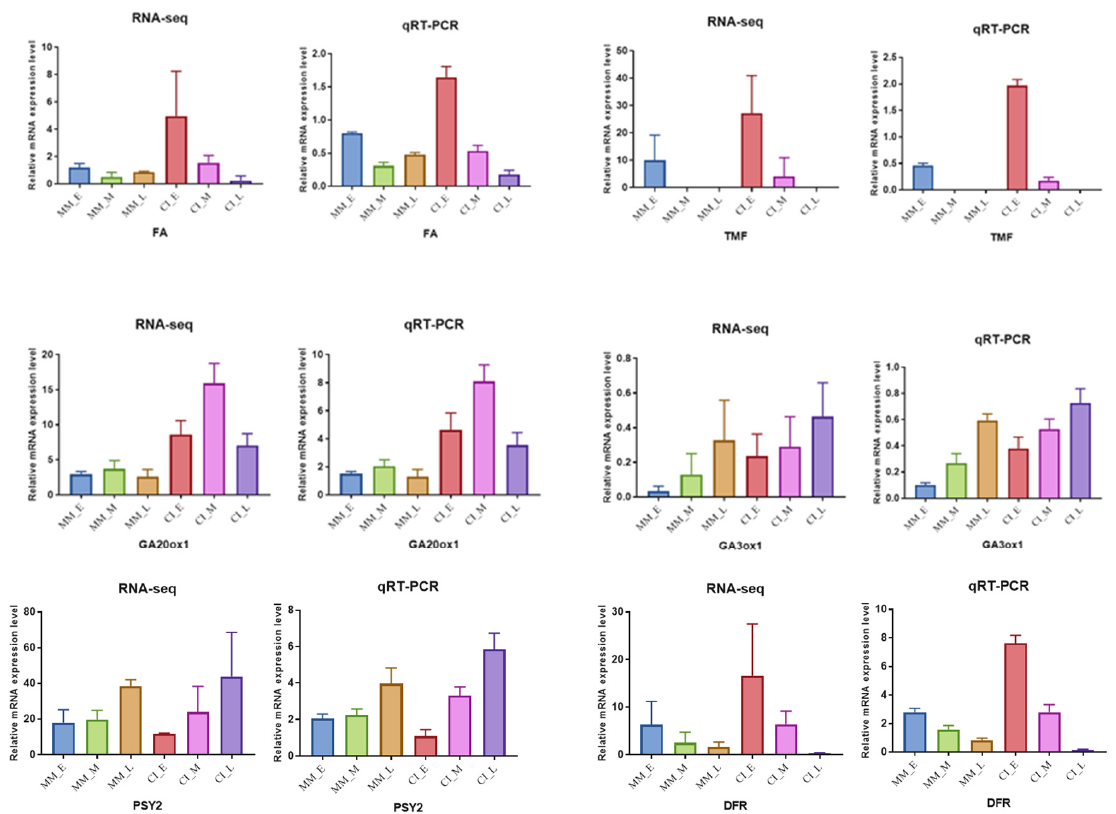
Figure 9. Comparative analysis of expression results between RNA-seq and qRT-PCR for 14 DEGs. Three technical replicates were performed for each biological replicate.